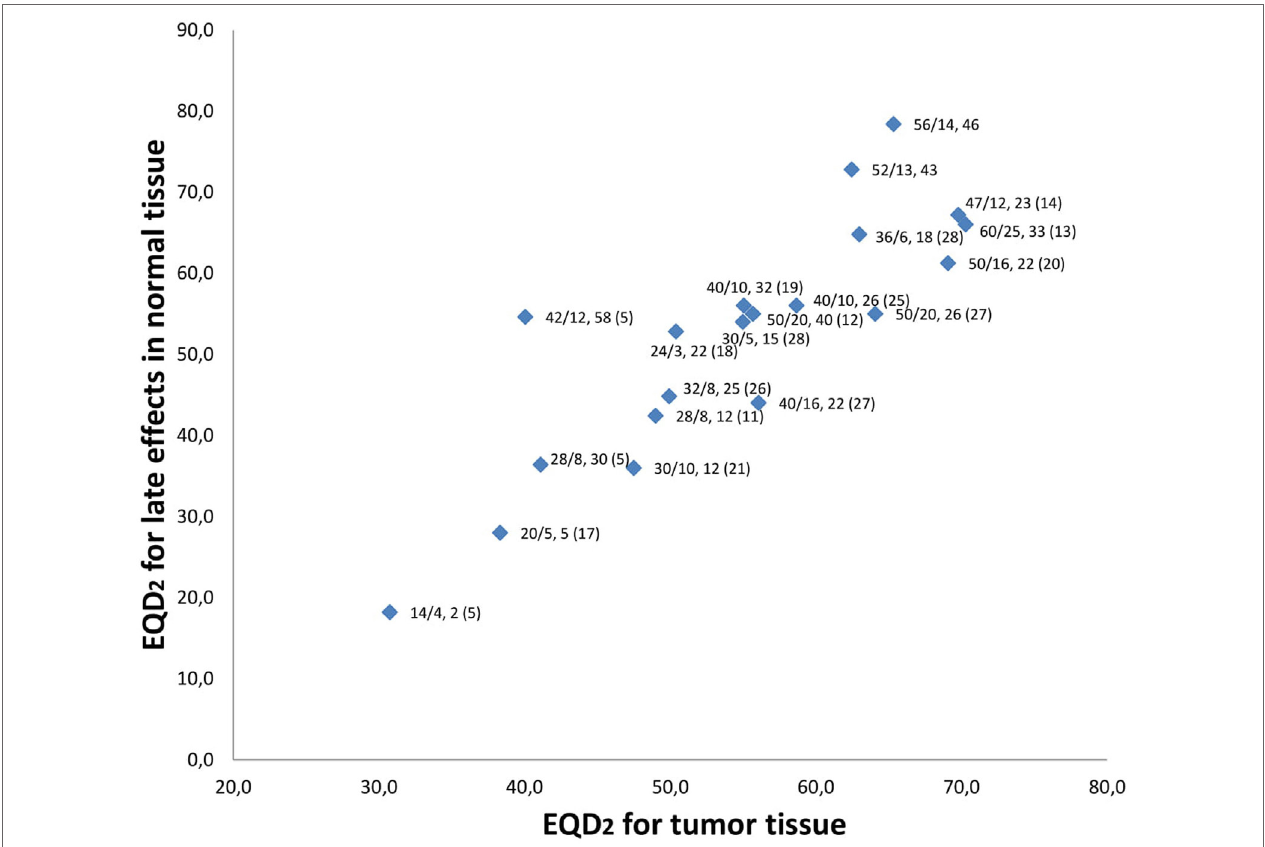
FigUre 2 | Relation between equivalent doses in 2-Gy fraction (EQD 2 ) for late effects in normal tissue and tumor tissue. Data labels are “dose given, (Gy)/number of fractions, overall treatment time (days) (reference).” Current study has no reference and is both shown for 52 Gy in 13 fx and 56 Gy in 14 fx. QUAD-shot represented with doses used by Corry et al. (5). Not all studies represented in Table 4 are referenced as some studies examined the same